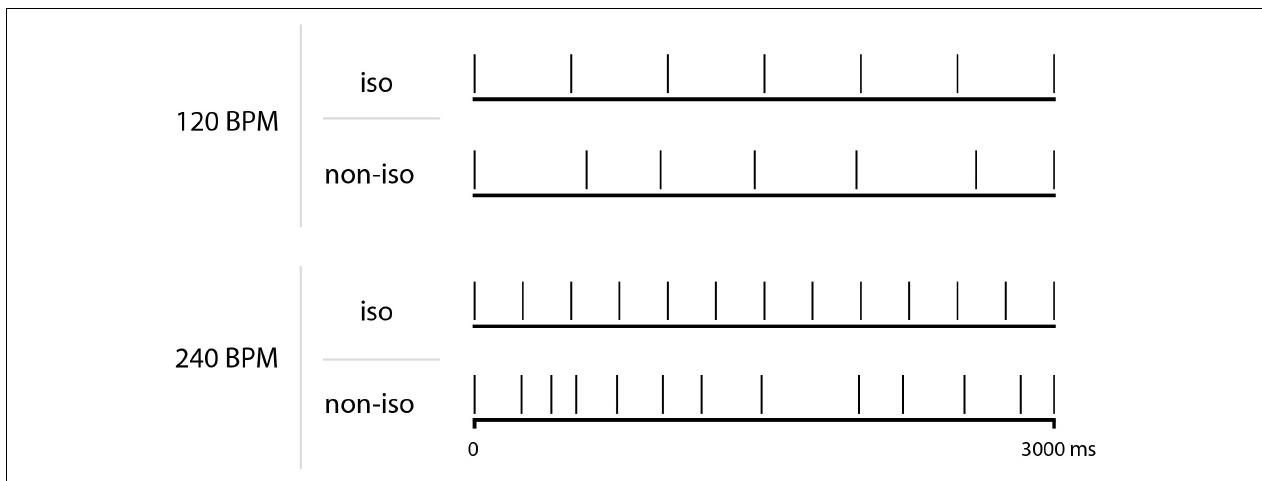
FIGURE 1 | Schematic representations of one isochronous (iso) and one non-isochronous (non-iso) auditory sequence, for each tempo (i.e., 120 and 240 BPM). Each vertical line represents a tone (see Table 1 for a complete description).